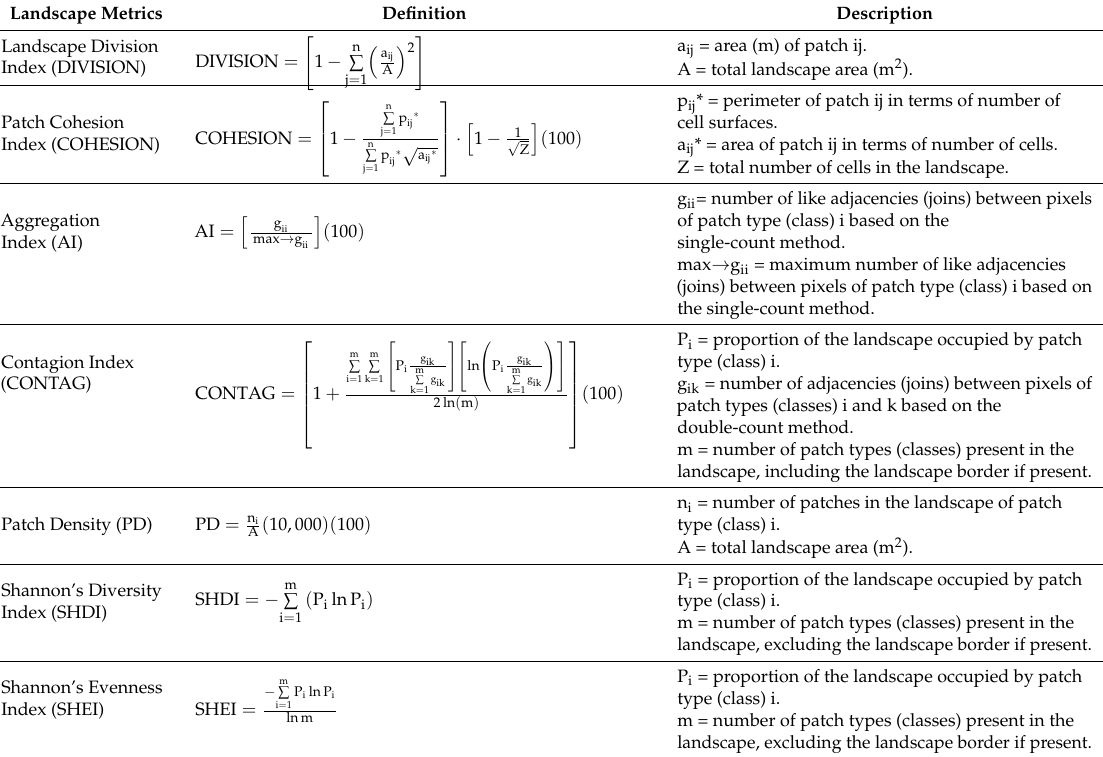
Table 2. Landscape metrics used in this study